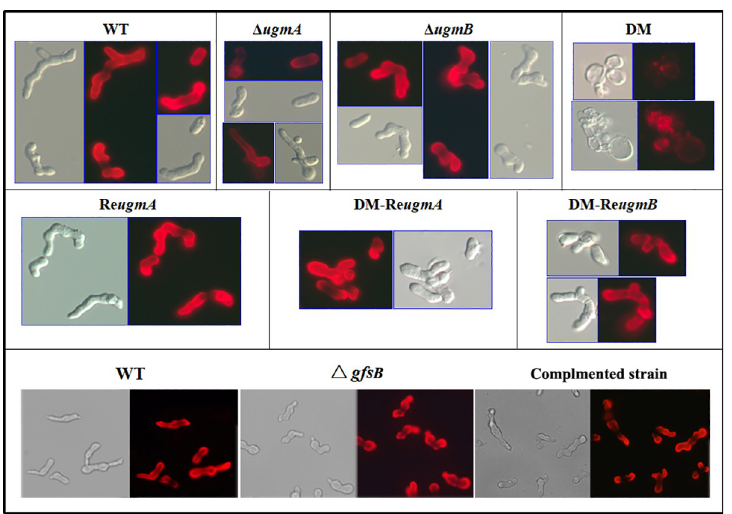
Fig 6. Detection of the galactomannan in the mutants with antibody AB135-8. Resting conidia were germinated for 8 h in PDB liquid medium and fixed with 2.5% pformaldehyde (PFA) overnight at 4˚C. After fixation, cells were washed with 0.2 M glycine in PBS for 5 min, then blocked with 5% BSA in PBS for 1 h. Cells were incubated with the anti-galactomannan monoclonal antibody at 1:10 dilution in 5% BSA in PBS for 1 h at room temperature. After washing with PBS-BSA 1%, cells were incubated with a goat Dylight 549-conjugated antibody directed against mouse IgG (H+L) diluted 1:2000 in BSA/PBS. After washing in PBS, cells were visualized with an inverted fluorescence light microscope. DM, double mutant; DM-Re ugmB , double mutant with a copy of re-introduced ugmB ; DM-Re ugmA , double mutant with a copy of re-introduced ugmA